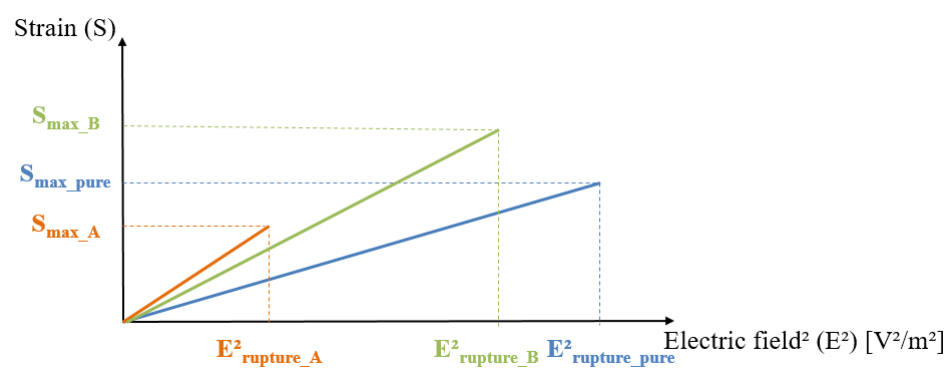
Figure 3. Strain versus electric field squares for different electrostrictive composites.